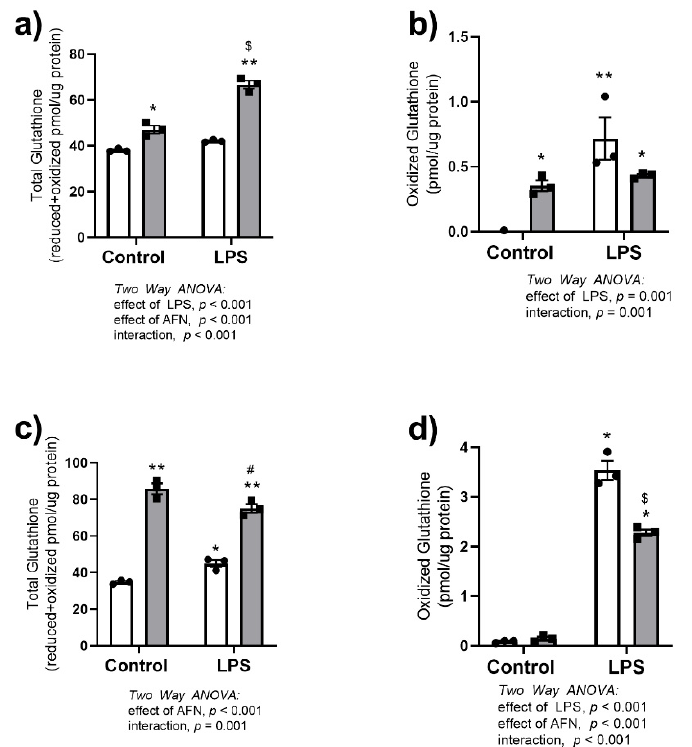
Figure 4. Total and oxidized glutathione are increased in response to AFN treatment. Cellular concentrations of ( a ) total glutathione (reduced + oxidized) and ( b ) oxidized glutathione were measured at 6 h, and ( c ) total glutathione (reduced + oxidized) and ( d ) oxidized glutathione were measured at 24 h in LPS and AFN-treated MH-S cells. White bars indicate DMSO control, and grey bars indicate AFN-treated. Data were analyzed by two-way ANOVA to identify the effects of LPS and/or AFN exposure. Tukey’s post-hoc analysis was used to determine significant differences between groups; n = 3 individual experiments. * p < 0.005 from control non-stimulated; ** p < 0.001 from control non-stimulated; # p <0.005 from AFN non-stimulated; $ p < 0.05 from control LPS.